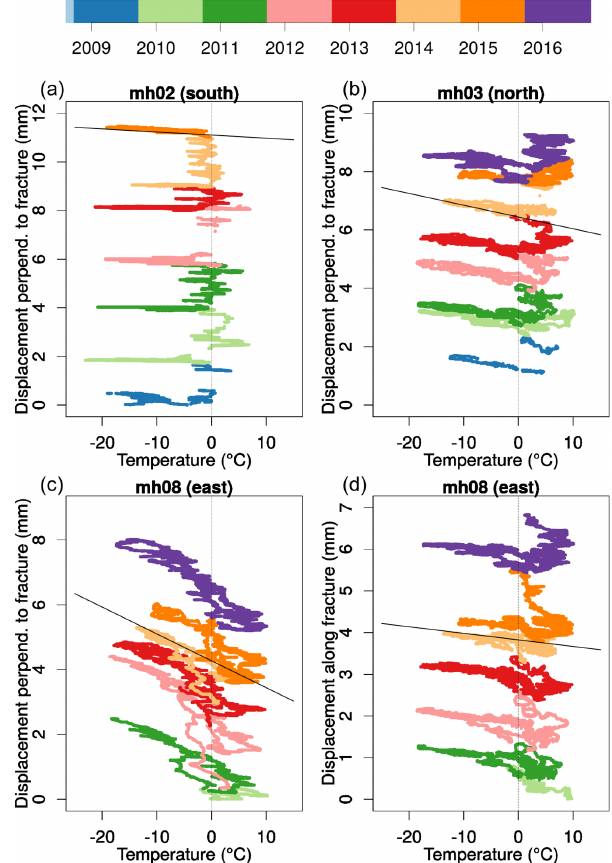
Figure 7. Temperature dependency of fracture displacements for location mh02 (perpendicular to fracture), mh03 (perpendicular to fracture) and mh08 (perpendicular to and along fracture). Discrete colors indicate hydrological years (1 October–30 September). Black lines indicate the linear regression function determined by the re- gression analysis (see Table